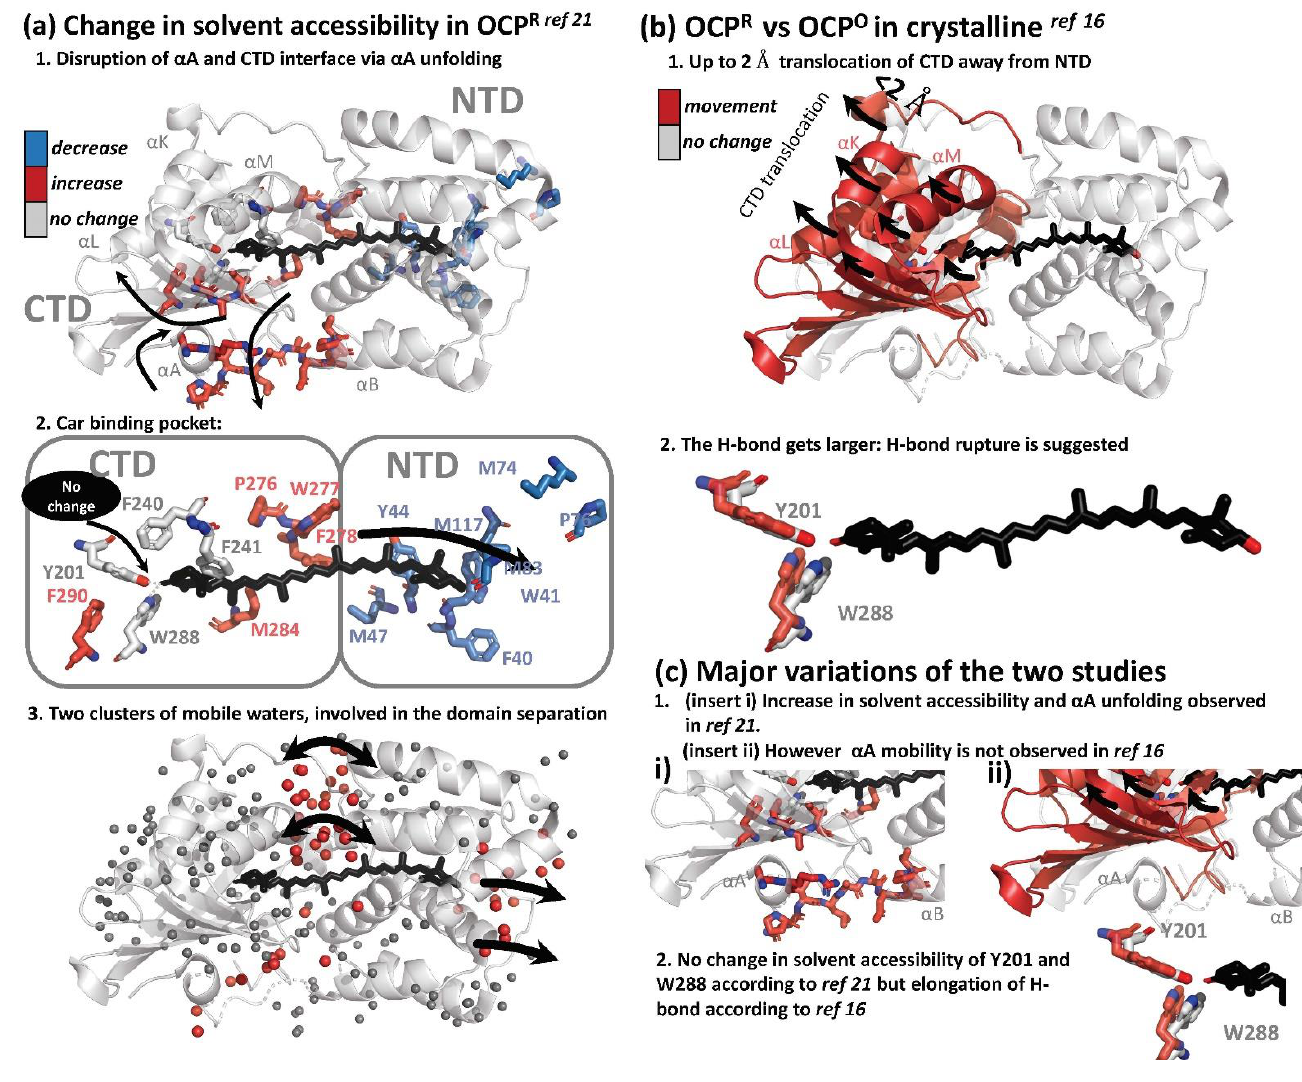
Figure 4. Summary of light-induced structural changes in OCP resolved by HDX-MS and XF-MS [21], and X-ray crystallography [16]. ( a ) Structural changes as resolved by HDX-MS and XF-MS [21]. The amino acids which showed an increase and decrease in solvent accessibility are colored in blue and red, respectively. Amino acids which showed no change in solvent accessibility are colored in grey. ( b ) Structural changes as resolved by T-scan X-ray crystallography [16]. Amino acids showing movement in illuminated crystals are colored in red. ( c ) Summary of the differences of the two studies.